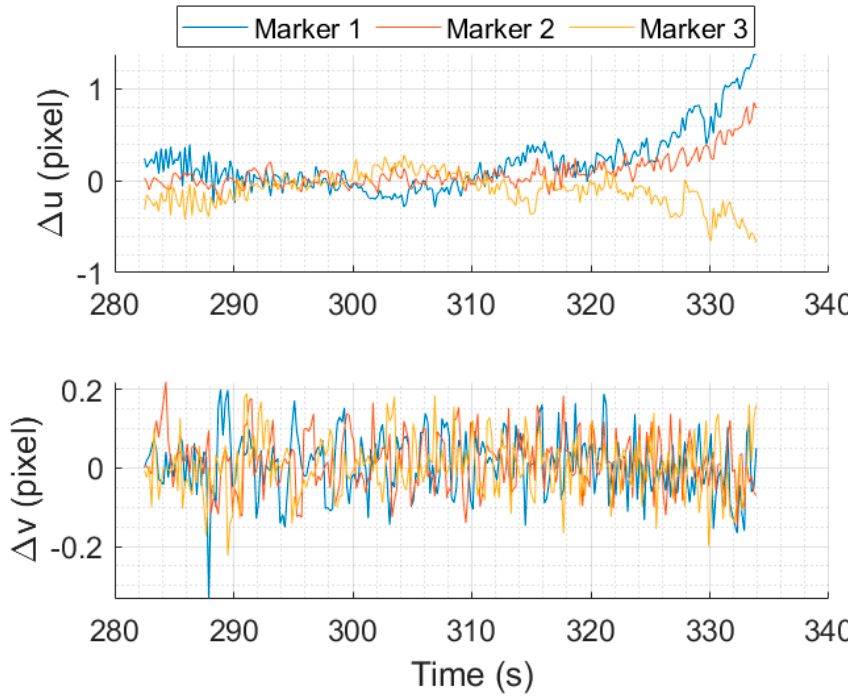
Table 17. Mean and standard deviation of the pose estimation errors for test case E-SB. Figure 20. Temporal evolution of the mean of the errors on the pose parameters, with representation of the 3 σ intervals, for test E-SB. The plots are focused on intervals about the mean values: the arrows indicate the maximum values reached by the pose initial guess at scenario start.